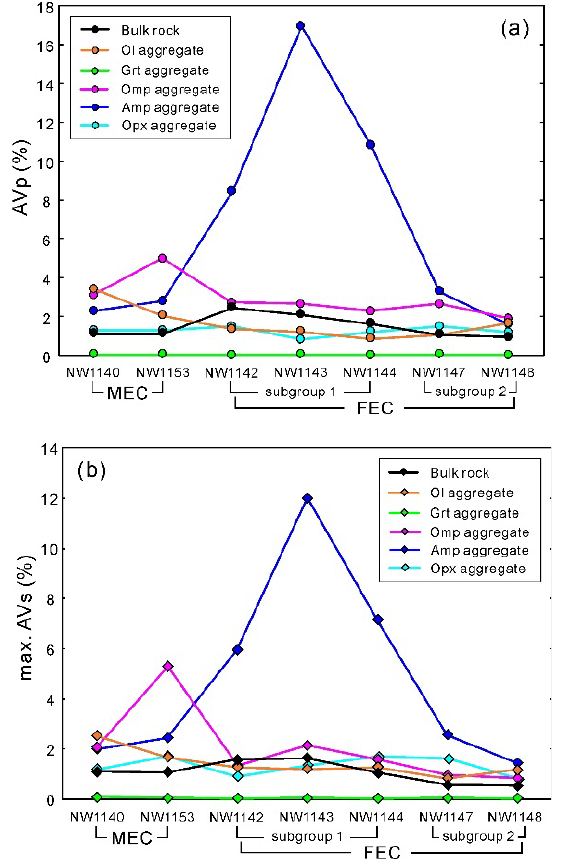
Figure 6. ( a ) AVp and ( b ) max. AVs of the bulk rock and mono-mineralic polycrystals in the MEC and FEC.